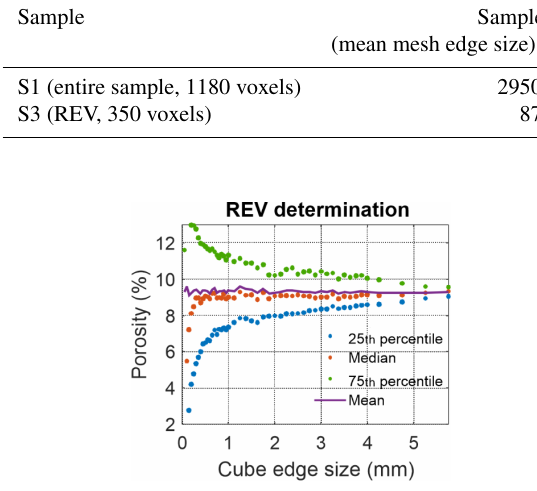
Figure 14. Classic REV analysis of S2. Investigated volume size is 7 . 9 × 6 . 8 × 9 . 2mm 3 .